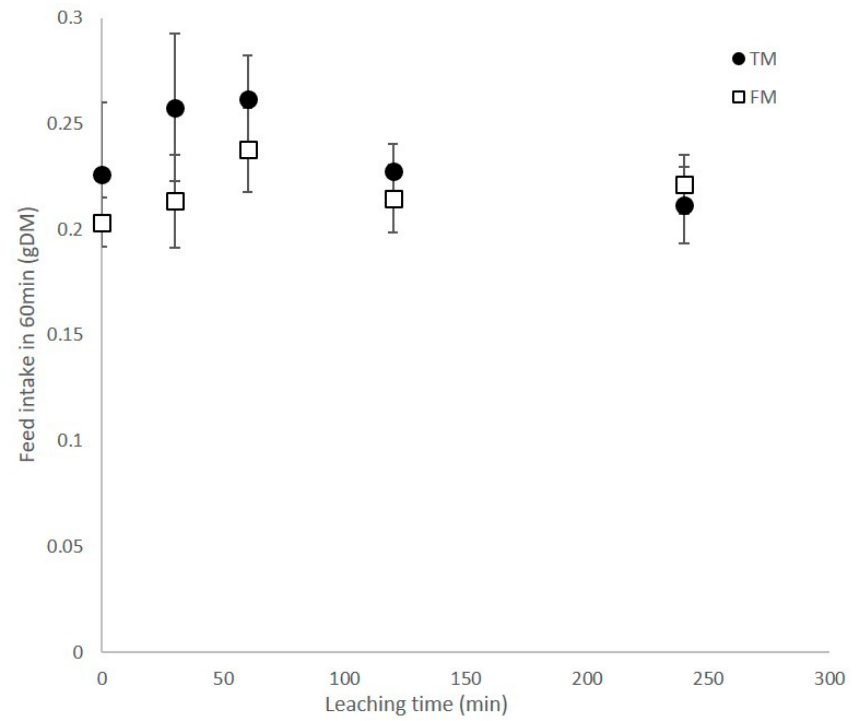
Figure 3. Feed intake over 60 min for shrimp fed diets that had been leached in situ for various times prior to feeding.